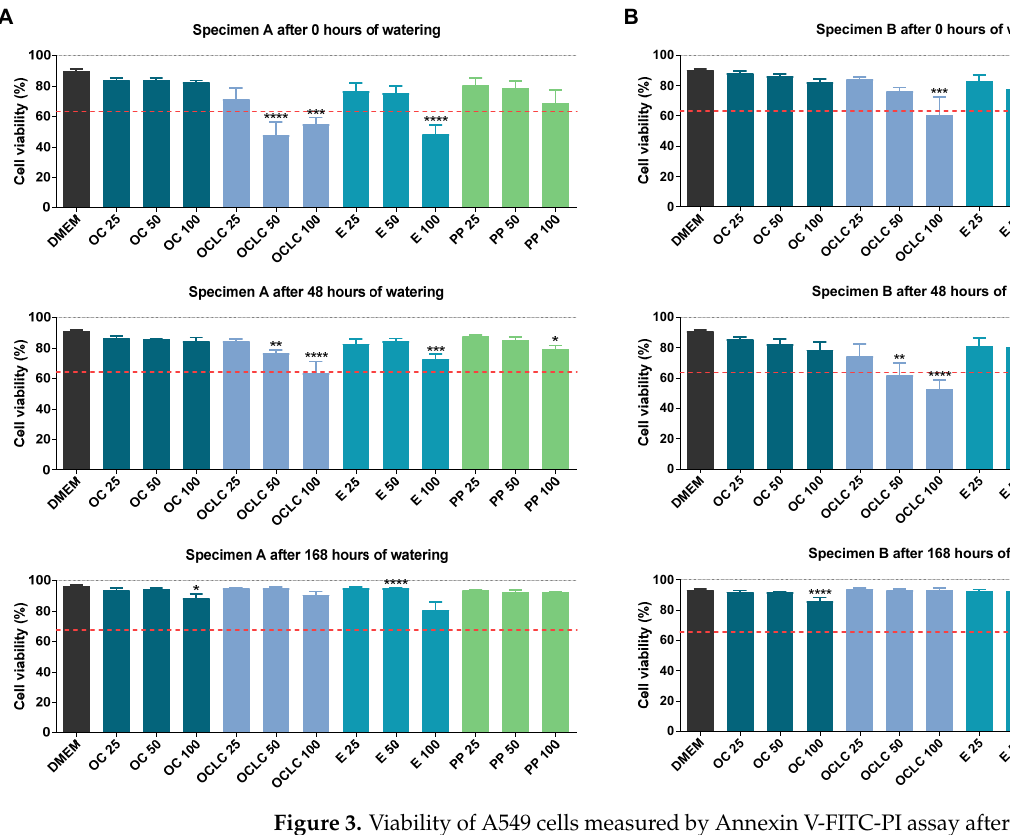
Figure 3. Viability of A549 cells measured by Annexin V-FITC-PI assay after incubation with eluates from ( A ) test specimens A (15 mm × 0.5 mm), ( B ) test specimens B (50 mm × 1.0 mm) or ( C ) test specimens C (50 mm × 3.0 mm) of different compositions (OC, Orthocryl ® ; OCLC, Orthocryl ® LC; E, Loctite ® EA 9483; PP, polypropylene) and previous watering conditions. The test specimens were stored in distilled water at room temperature for 0, 48 or 168 h followed by a 24 h storage in cell culture medium (DMEM, Dulbecco’s Modified Eagle Medium) under shaking conditions. The DMEM eluates were used undiluted (100%) or diluted (50 and 25%) for a 24 h incubation of A549 cells followed by determination of cell viability using the Annexin V-FITC-PI assay. Percentages refer to the sum of all cell populations measured in FACS analysis per treatment group (set to 100%). The data are mean values ± SEM of n = 3–4 ( A ) or n = 4 ( B , C ) per group. * p ≤ 0.05, ** p ≤ 0.01, *** p ≤ 0.001, **** p ≤ 0.0001 vs. DMEM control; one-way ANOVA with Dunnett’s post hoc test. The dashed red line shows the 30% deviation of the treatment groups from the control value (DMEM group).